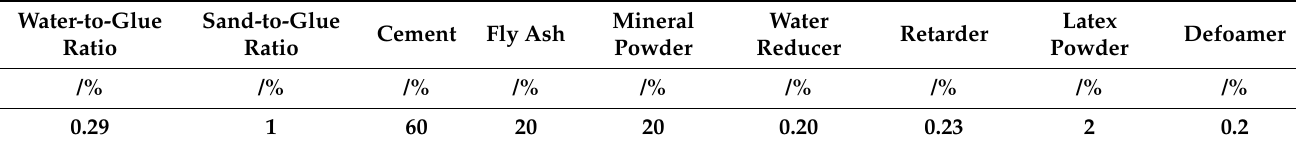
Table 14. Mix ratios of 3D printed concrete.